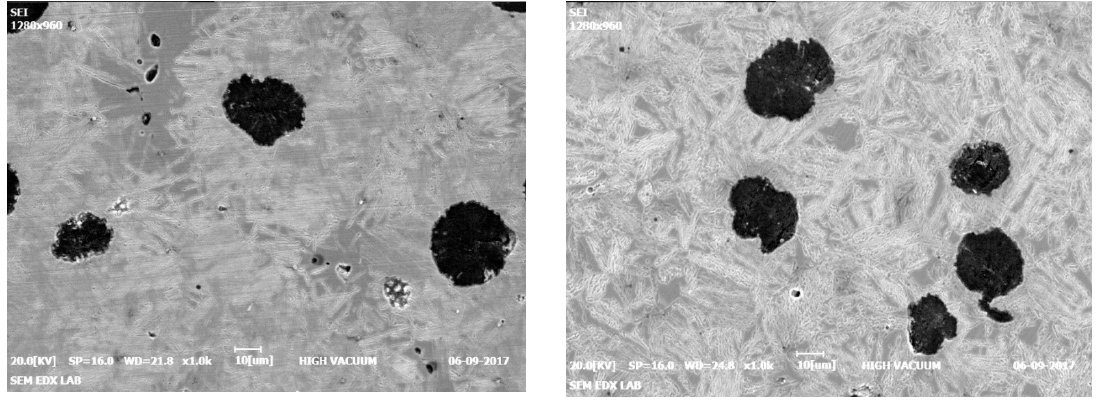
Figure 5. SEM image for samples austenitized at 950ºC and austempered at 420ºC with 0.26 wt% Mn.